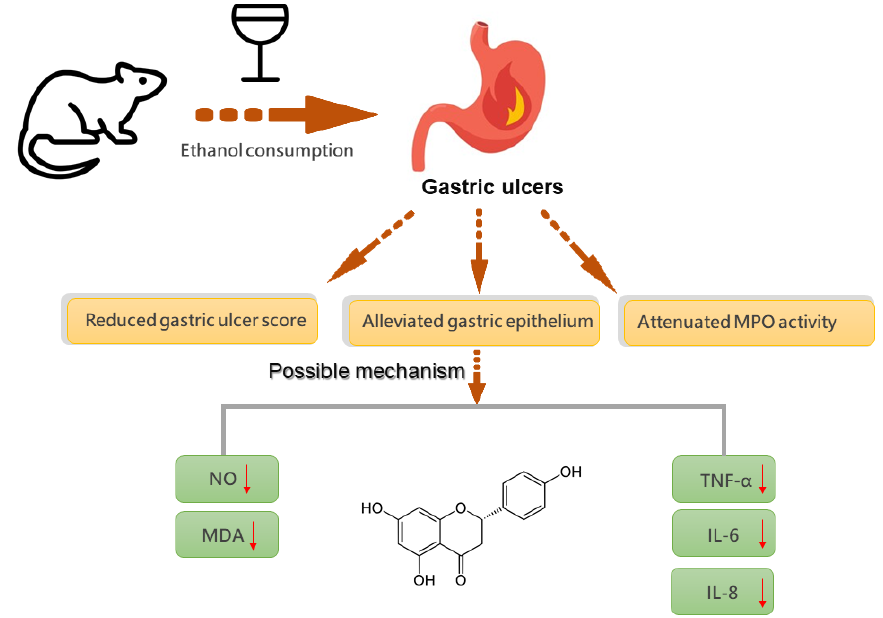
Figure 8. The gastroprotective mechanism of naringenin against ethanol-induced gastric ulcers.